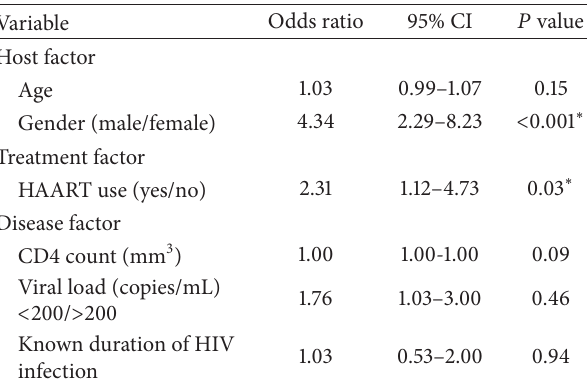
Table 5: Logistic regression of factors predicting the development of lipoatrophy in the patients with HIV